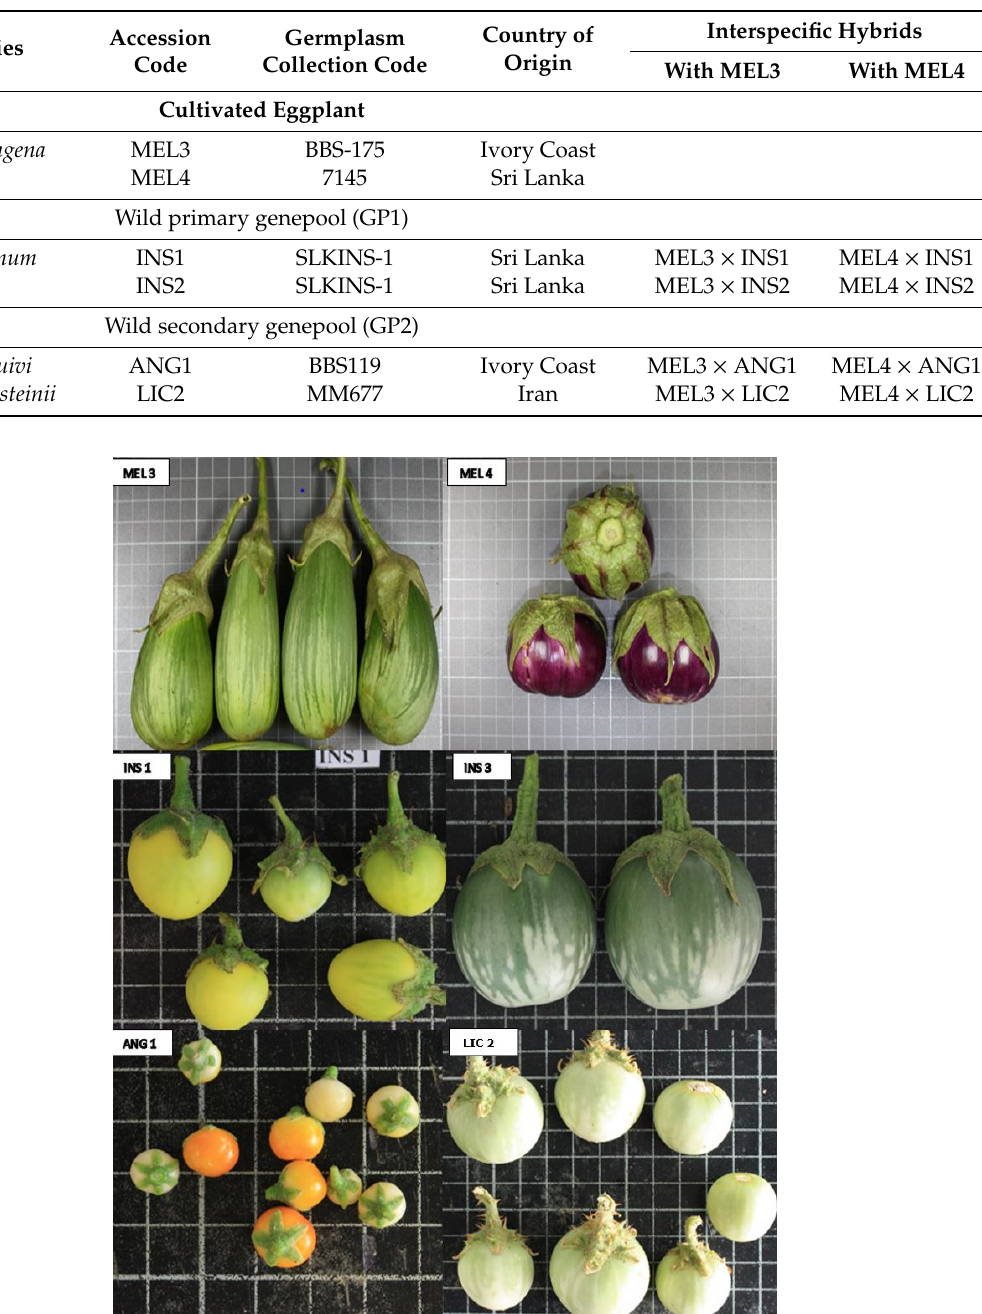
Figure 1. Fruits of six eggplant accessions used in the Line × Tester study.